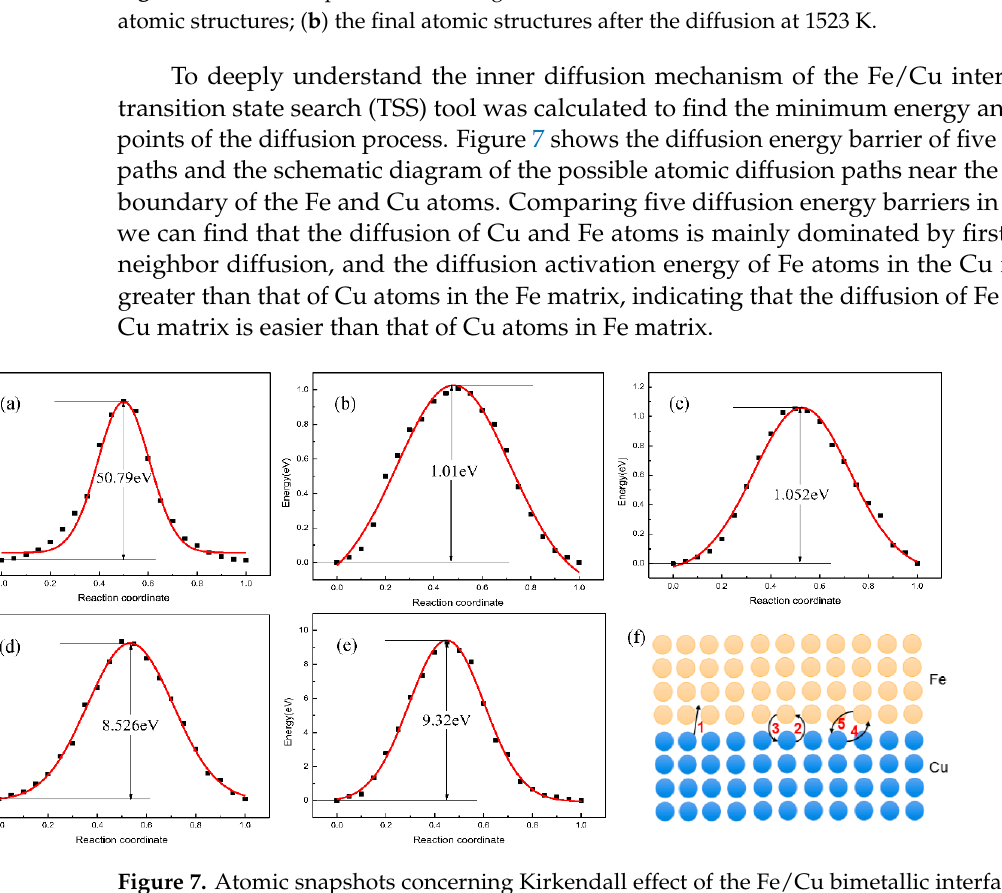
Figure 7. Atomic snapshots concerning Kirkendall effect of the Fe/Cu bimetallic interface. ( a ) the diffusion energy of the interstitial diffusion path of Cu atom; ( b ) the diffusion energy of the first nearest neighbor diffusion path of Cu atom; ( c ) the diffusion energy of the first nearest neighbor diffusion path of Fe atom; ( d ) the diffusion energy of the second nearest neighbor diffusion path of Cu atom; ( e ) the diffusion energy of the second nearest neighbor diffusion path of Cu atom; ( f ) schematic diagram of diffusion mechanism of Fe/Cu diffusion